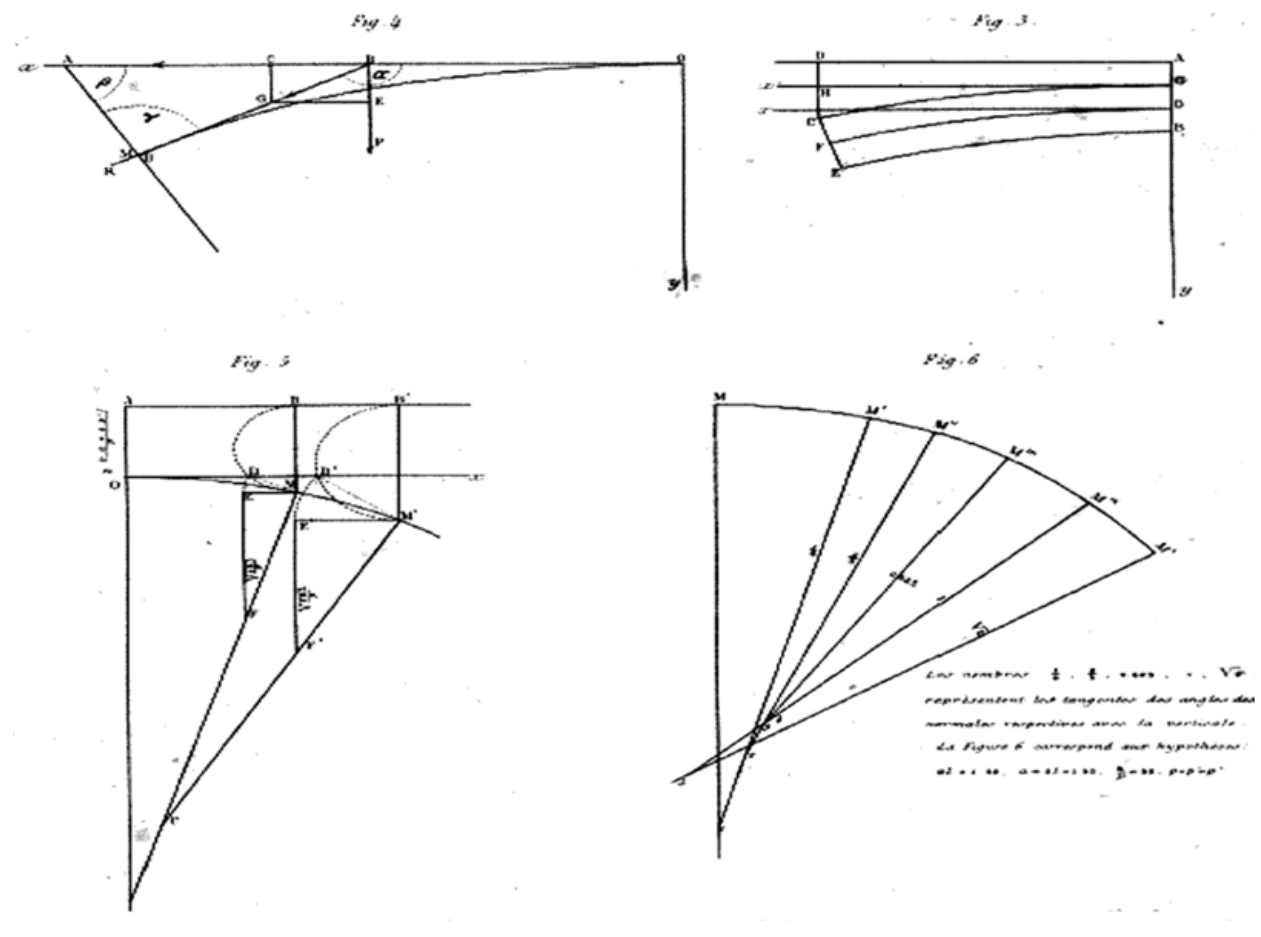
Figure 27. Graphic and geometric calculation of barrel vaults. Part of the article written by M. Denfert Rochereau in the magazine “Revue G é n é rale et des Travaux Publics”. France, 1859. Vol.7, (Pl.54). Edited by C é sar Daly Reference [47].